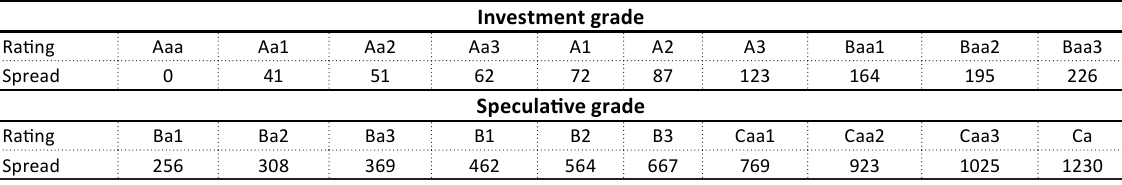
Table 5. Rating and risk spreads (January